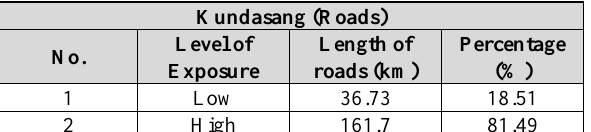
Table 11. Level of building exposure toward hazard in Kundasang